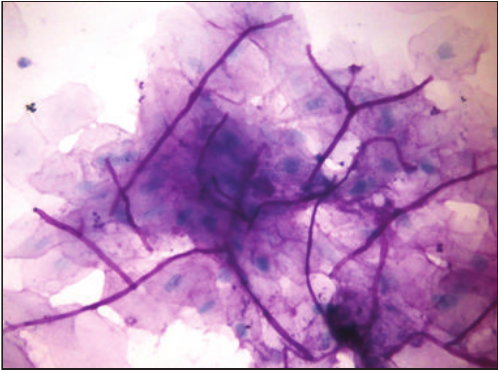
Figure 4: Photomicrograph of the exfoliative smear (40x) showing candidal